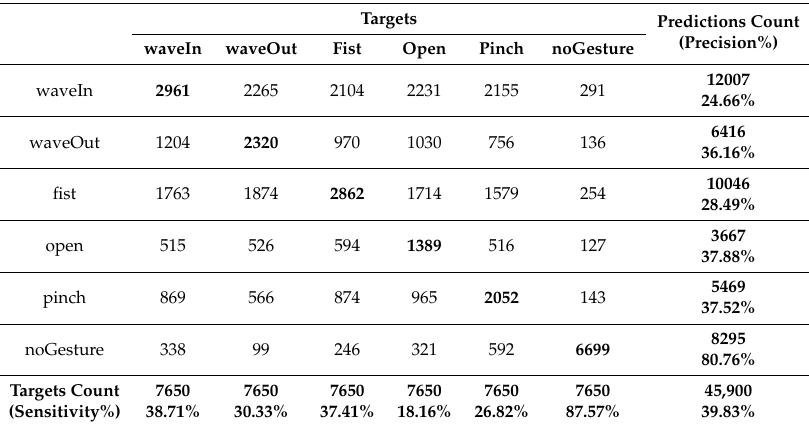
Table 4. Confusion matrix of experiment 2 for the user-specific model. Rotation of the bracelet = YES (on the test set), orientation correction = NO . The sync gesture was not used. Classification accuracy = 39.83%.